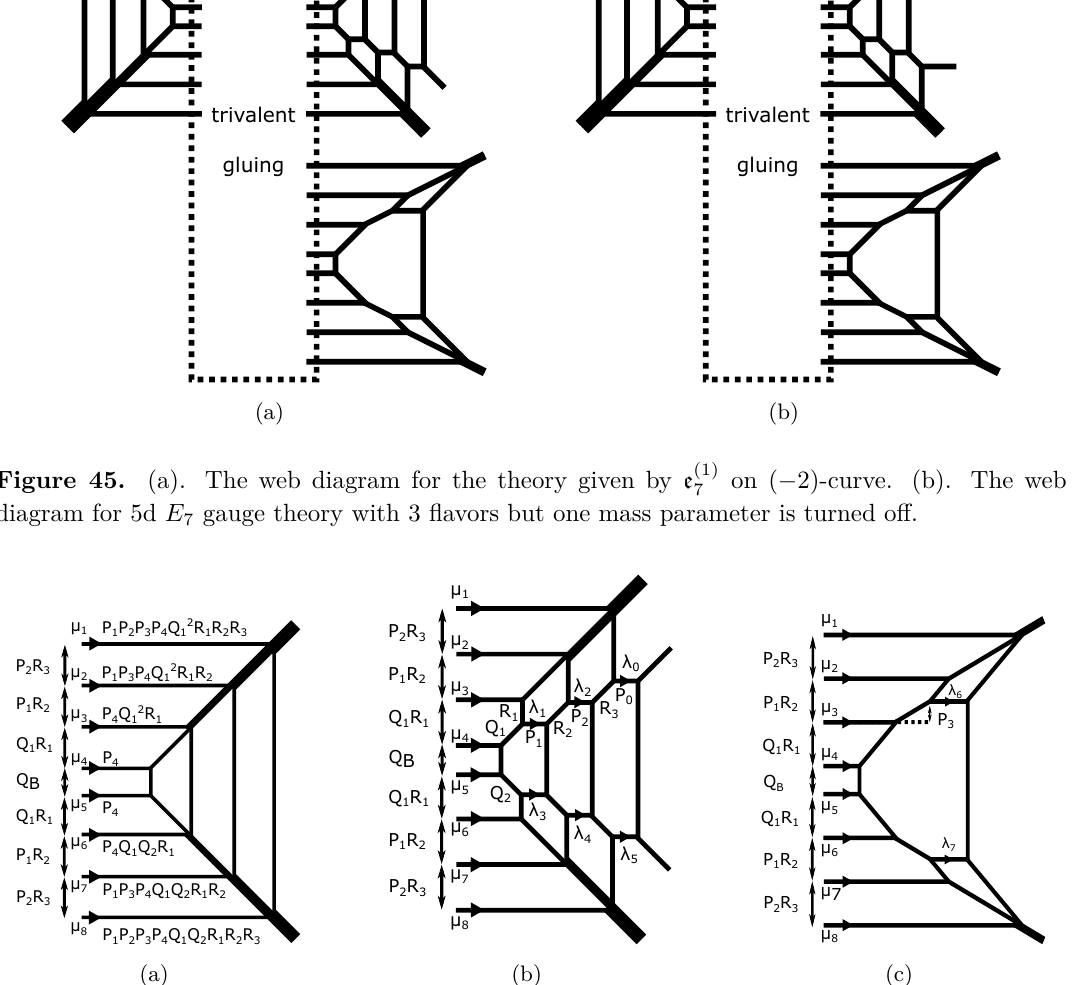
on ( − 2) -curve in figure 7